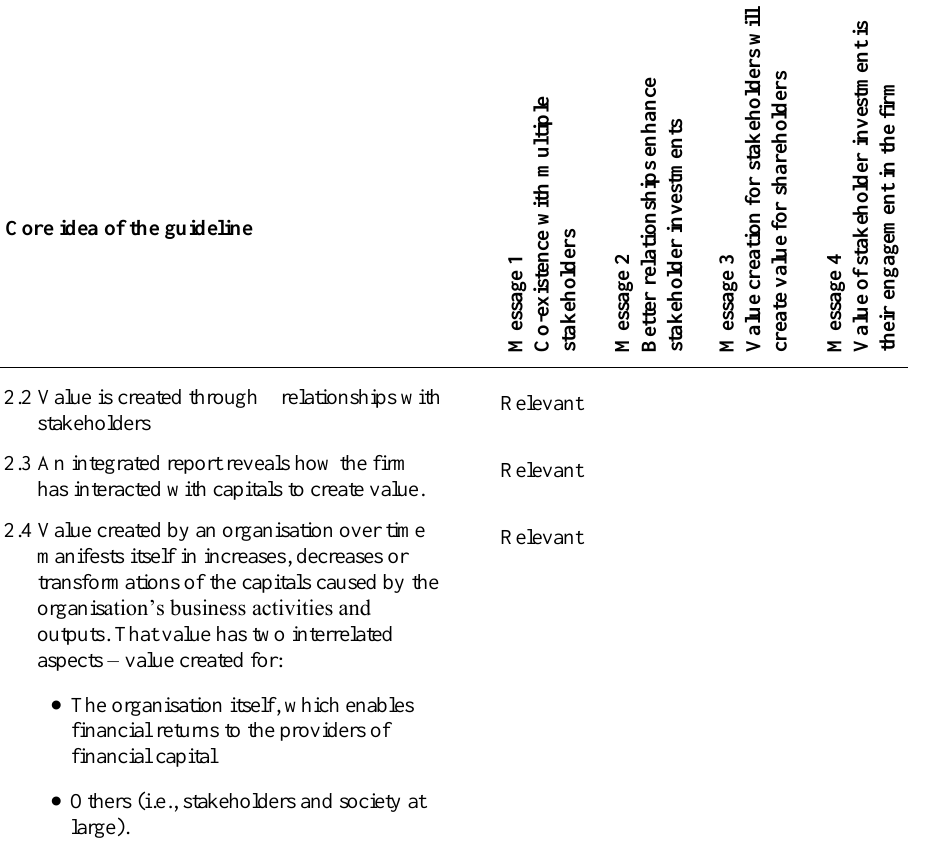
Core idea of the